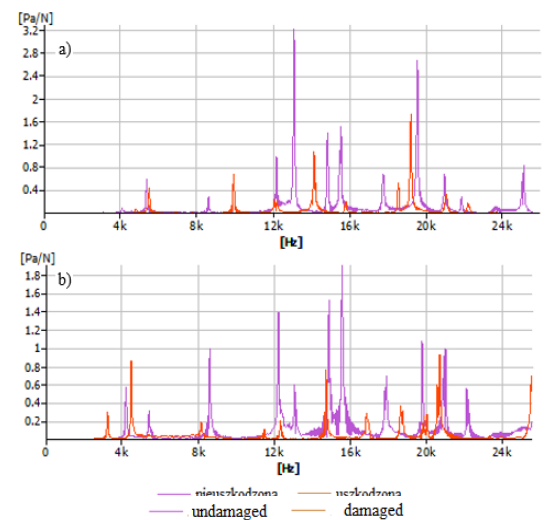
Fig. 6. Comparison of the sound amplitude spectrums: a) blade no. 5 before and after damage, b) blade no. 10 before and after